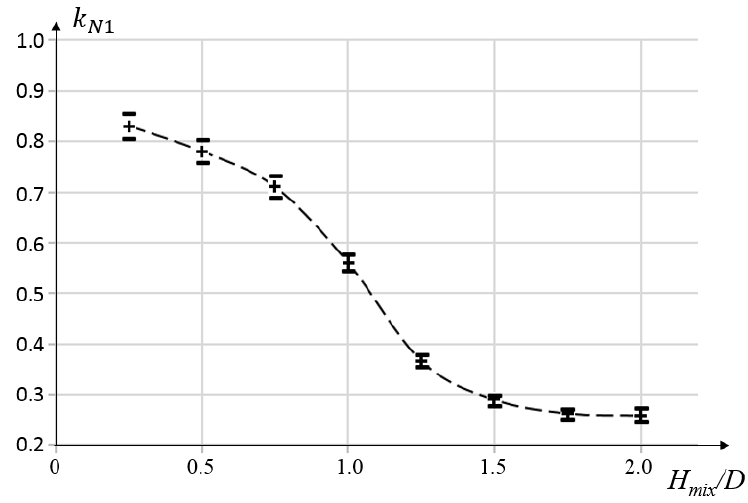
Figure 5. Influence of the ratio H mix / D on the power k N 1 spent on mixing (experimental data).